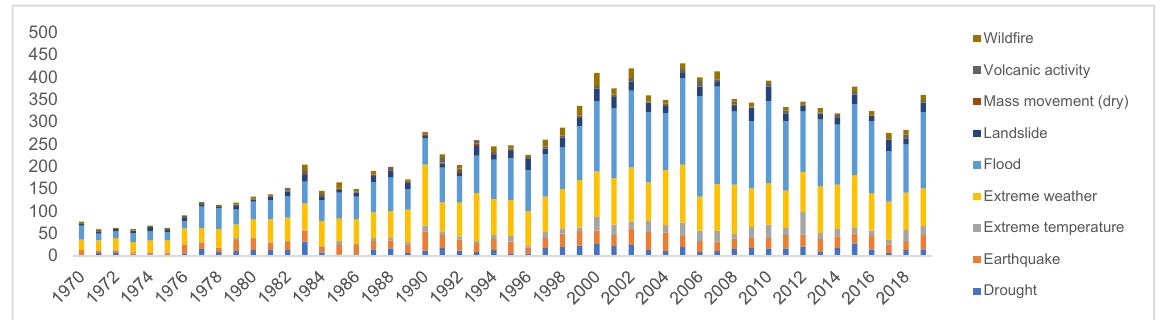
Figure 1. Global Reported Natural Disasters by Type, 1970 to 2019 (Our World in Data 2019). During the COVID-19 pandemic, greenhouse gas emissions dropped just by 5% (Na- tional Aeronautics and Space Administration 2021), suggesting that the race to net-zero